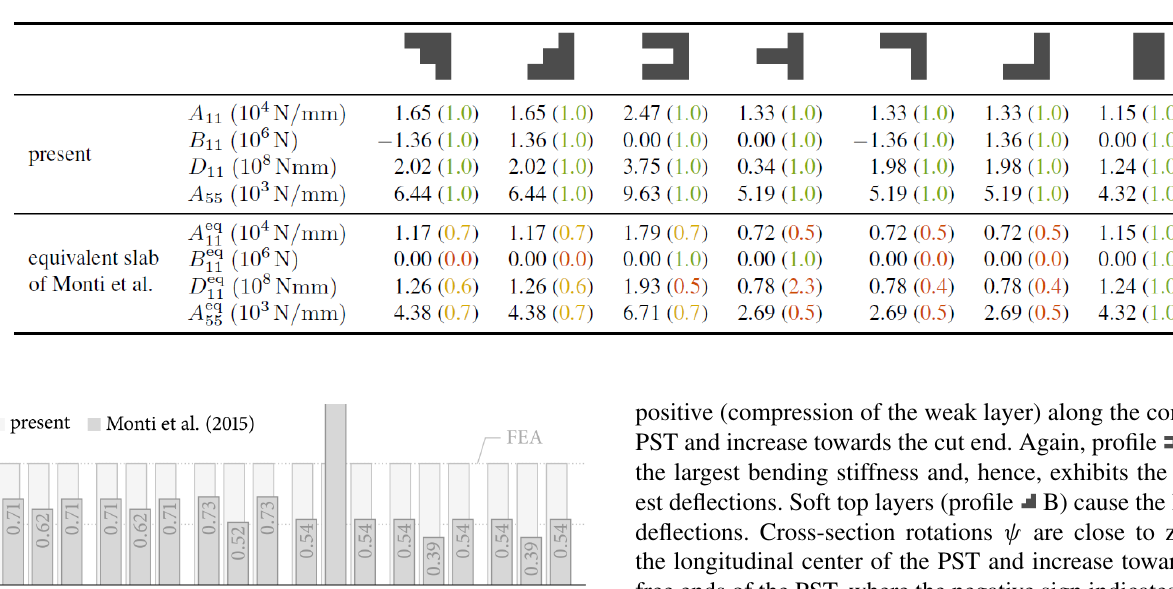
Table 3. Slab extension, coupling, bending, and shear stiffnesses of the benchmark profiles. Comparison of A 11 ,B 11 , D 11 , and A 55 of ,B eq the present model with A eq , D eq , and A eq obtained from an equivalent isotropic slab according to Monti et al. (2016). Numbers in 11 11 11 55 parentheses indicate the ratio of the modeled stiffness to the corresponding stiffness obtained from finite-element analyses (visualized in Fig. 11). Layer configurations as detailed in Fig. 5 are used.